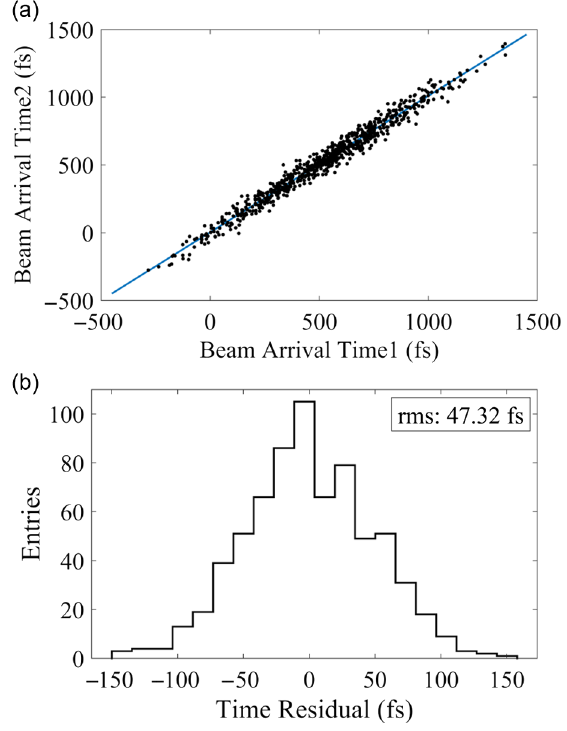
15. Arrival times measured by two BAMs (a). Distribution